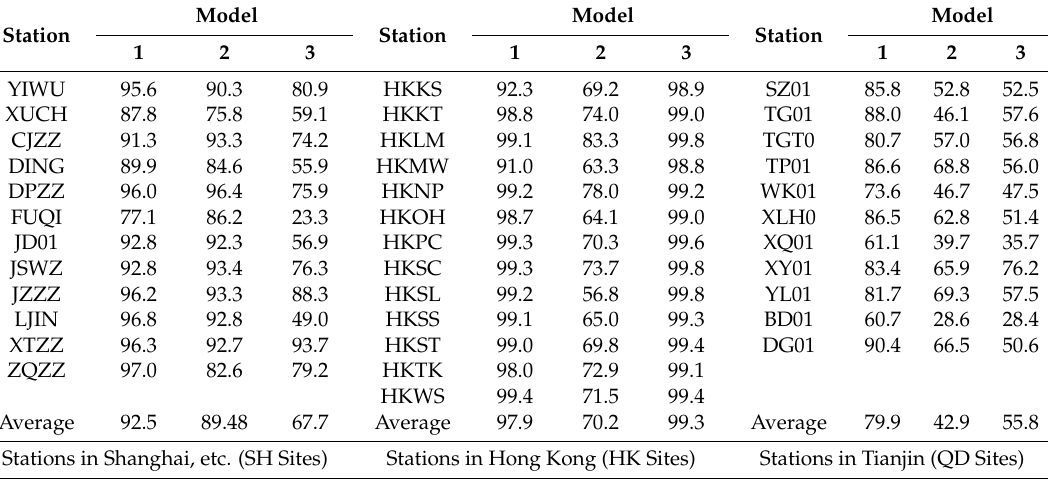
Table 4. Percentage of epoch ambiguity fixed rates for RTPPP-AR of Different Regional Stations in Different UPD Models (reference station coordinates are set to known).